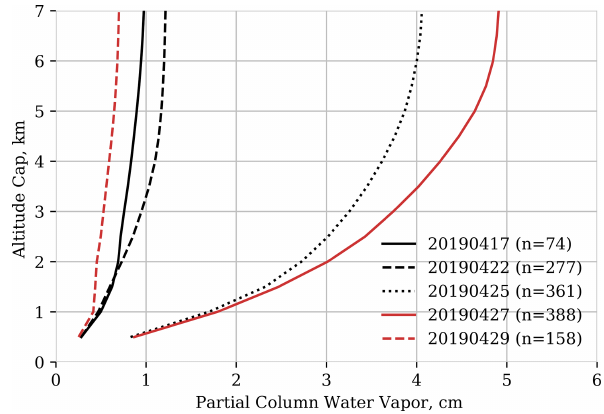
Figure 11. Partial column water vapor for five HALO flights calcu- lated at different capping altitudes.